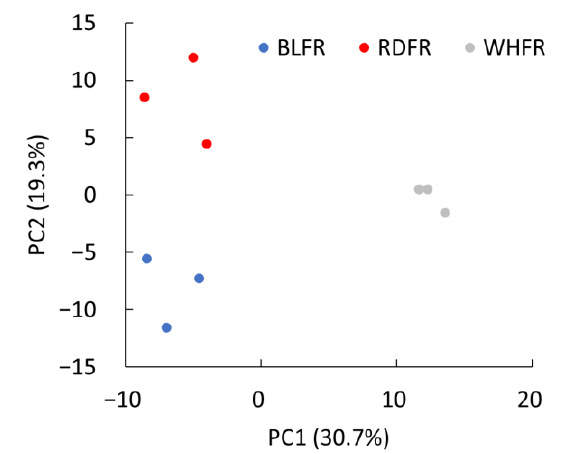
Figure 1. PCA of metabolic profiles in fruits with different light treatments. PCA scores are presented based on a combination of the first (PC1) and second (PC2) principal components and variances of each component in the sample set. BLFR, RDFR, and WHFR refer to blue, red, and white light-treated fruits.